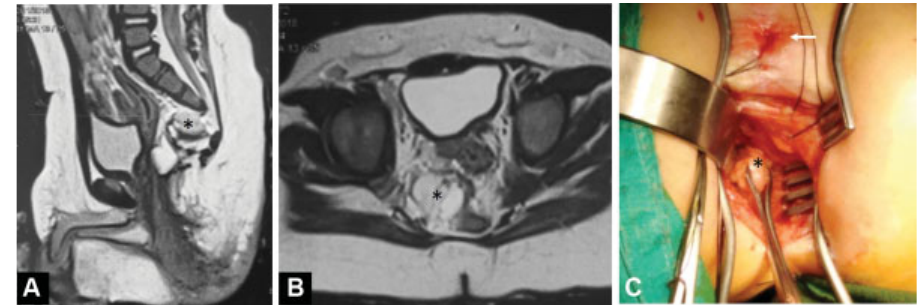
Fig. 2 Follow-up magnetic resonance imaging (MRI) study performed after posterior sagittal anorectoplasty showing a residual presacral mass ( (cid:3) ) in midsagittal T2-weighted image ( A ) and axial T2-weighted image ( B ). ( C ) Reoperation in the supine lithotomy position to remove the residual presacral mass ( (cid:3) ); note: the incision is posterior to the neoanus ( white arrow